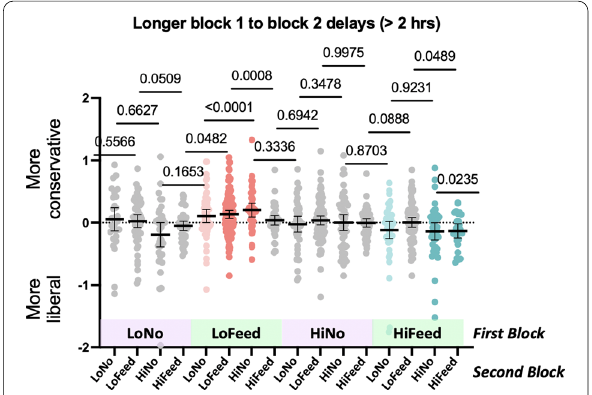
Fig. 7 Change in criterion on block 2 as a function of the nature of block 1. Data restricted to pairs separated by more than 2 h